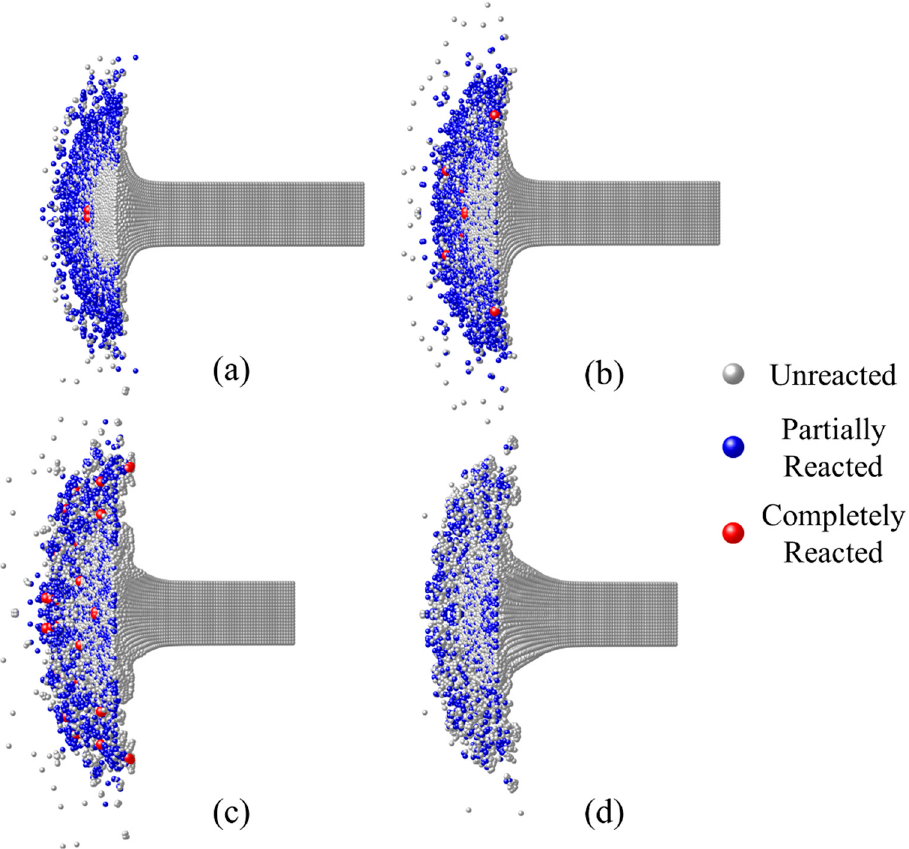
Figure 12. Reaction morphology of RM rod at the time for the first light of different impact velocities: